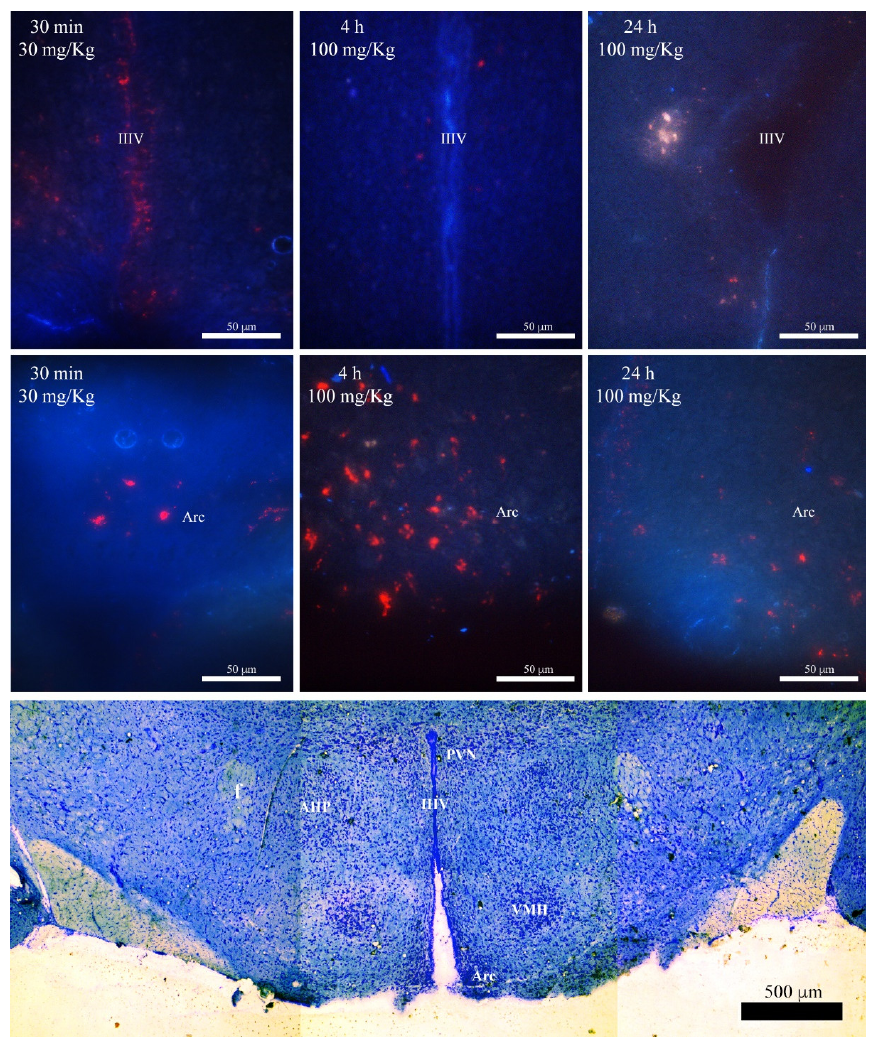
Figure 3. Microphotographs of brain from adult rats receiving 30 or 100 mg/Kg, i.p., of the flavonoid quercetin (aglycone, upper panel) and its glycoside rutin (intermediate panel). Representative coronal sections at 20 µm, around bregma −2.16 mm (bottom panel), were stored at −80 °C and then thawed to be observed with a blue filter for DAPI (UV excitation 340–380 nm/emission 425 nm) under the epifluorescence microscope. Horizontal micrograph at the bottom shows the location of the hypothalamic nuclei where quercetin and rutin were observed (Arc = arcuate nucleus) and the third ventricle (IIIV) in three contiguous images of a brain section stained with Nissl. Other hypothalamic nuclei negative to quercetin and rutin are also shown. AHP = anterior hypothalamic area; PVN = paraventricular nucleus; WMH = ventromedial hypothalamic nuclei; f = fornix. Scale bars in upper panels = 50 µm; scale bar at the bottom = 500 µm.